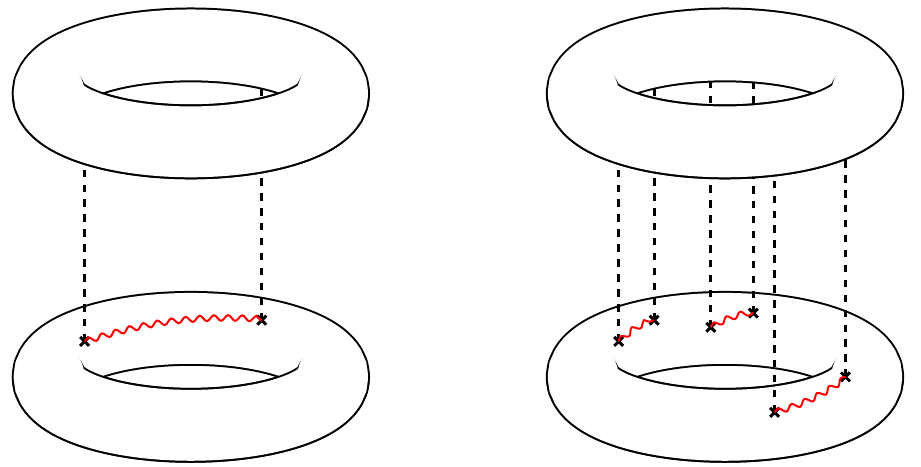
Figure 12 . Degree 2 branched covering maps appearing in conformal perturbation away from the symmetric product orbifold. The left figure shows the surface that appears at second order in conformal perturbation theory. The right surface appears at higher order in perturbation